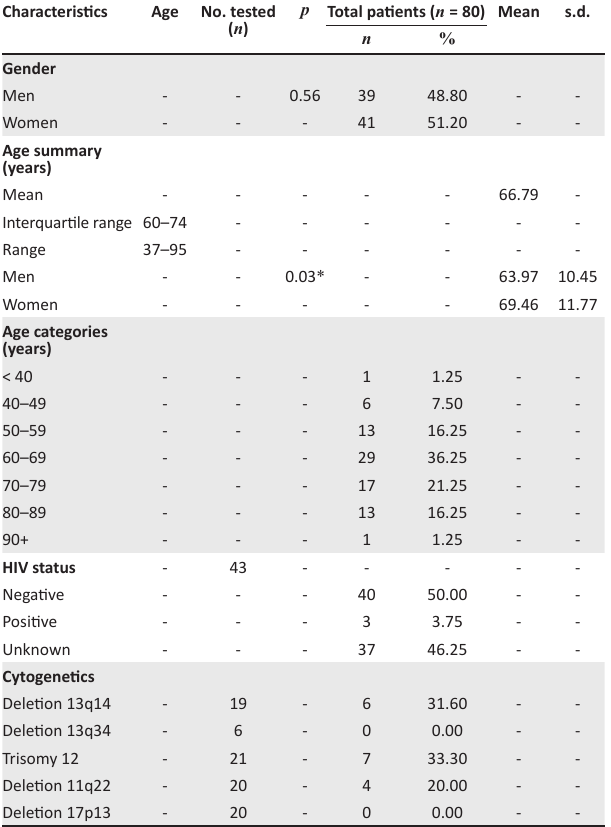
TABLE 1: Characteristics of newly diagnosed chronic lymphocytic leukaemia cases at TAH, 2011–2016. Characteristics